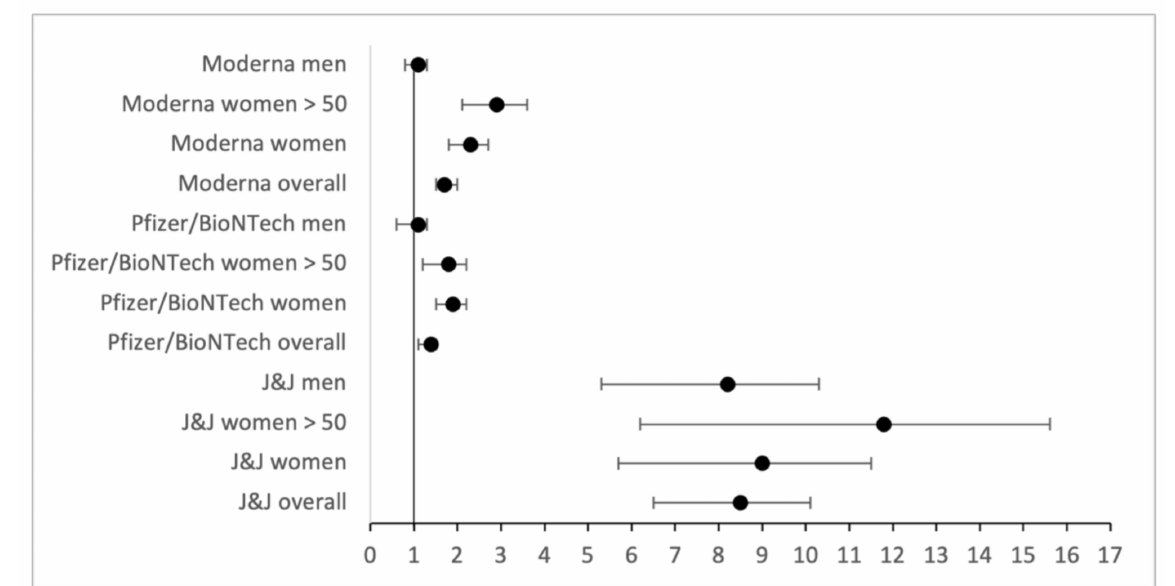
Figure 2. Odds ratios and confidence intervals for GBS, based on a general incidence of 17.7 [25].